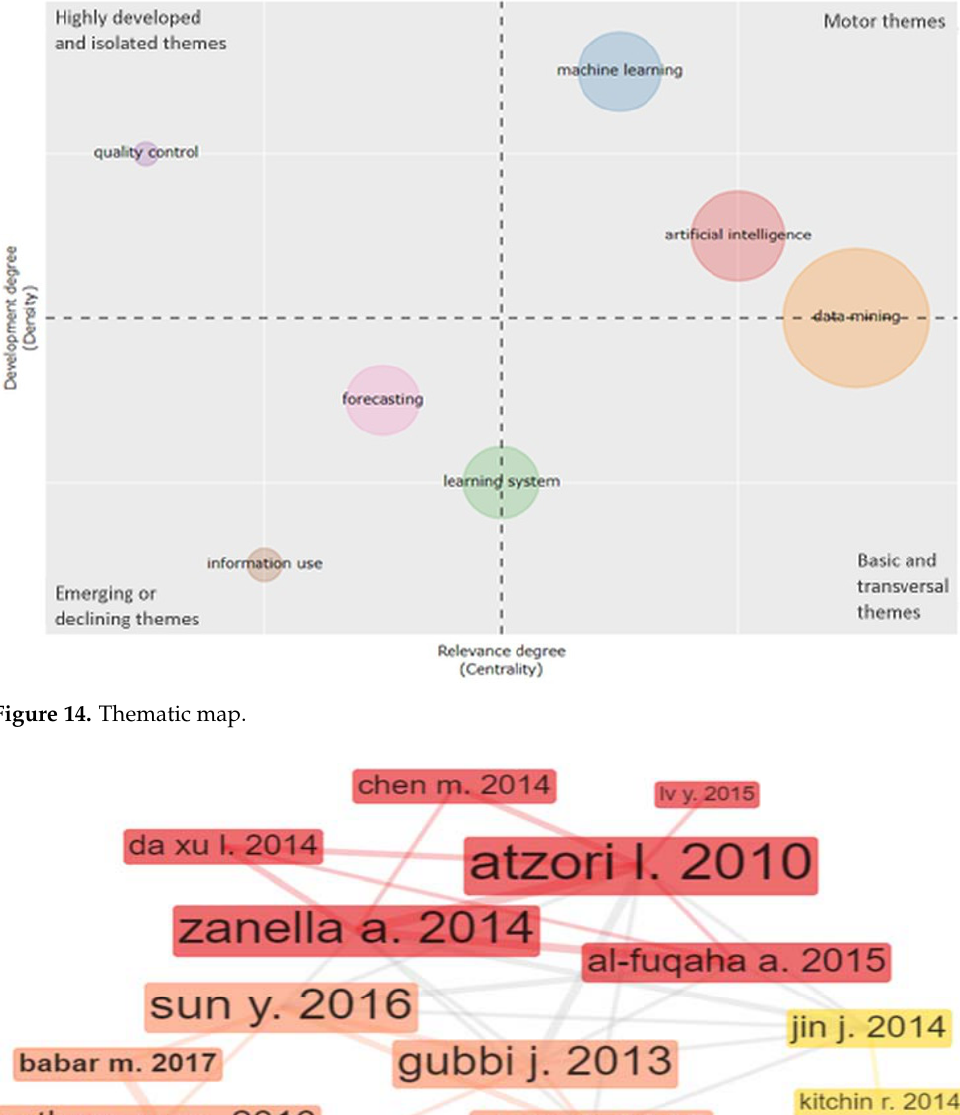
Figure 13. Topic dendrogram.